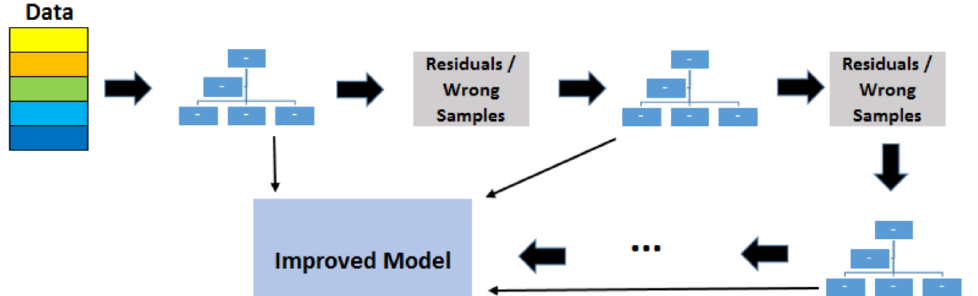
Figure 6. Extreme Gradient Boosted